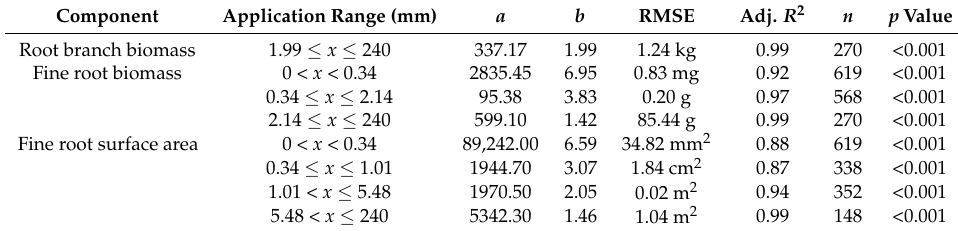
Table 2. Summary of parameters and prediction statistics for biomass and surface area of first-order root branches related to basal diameter. The power function of y = ax b was applied for all equations, where y represents biomass (mg) or surface area (mm 2 ), x represents root diameter (mm), a and b are coefficients. All models had the basal diameter of the first-order root branch as the independent variable. Root branch biomass with a diameter less than 1.99 mm was calculated by the fine root biomass model. RMSE: Root mean squared